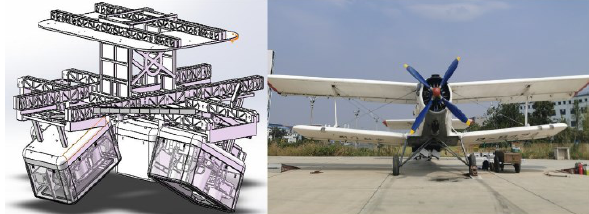
Figure 6. Structure diagram and flying platform of CKAC300